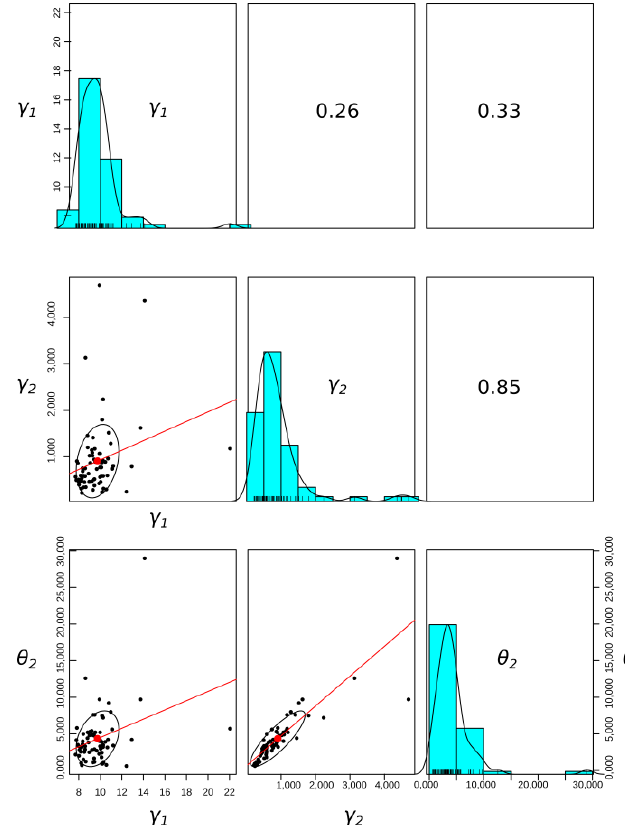
Figure 11. Graphical representation of Pearson covariance matrix with histograms. Fitting of linear relationships between parameters was performed for parameter values from both wings. The position of the graph in the figure is indicated by (row,column): (1,1) histogram of 𝛾 1 , (2,2) histogram of 𝛾 2 , (3,3) histogram of 𝜃 2 , (1,2) correlation coefficient between 𝛾 1 and 𝛾 2 , (1,3) correlation coefficient between 𝛾 1 and 𝜃 2 , (2,3) correlation coefficient between 𝛾 2 and 𝜃 2 , (2,1) plot of 𝛾 1 vs. 𝛾 2 , (3,1) plot of 𝛾 1 vs. 𝜃 2 , (3,2) plot of 𝛾 2 vs. 𝜃 2 .